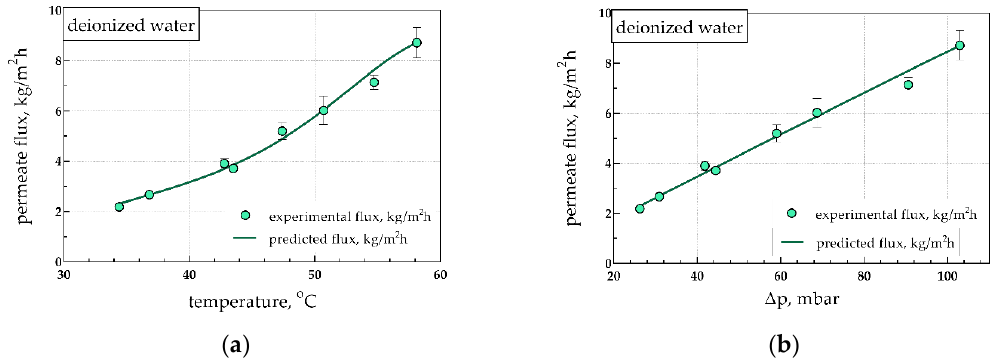
Figure 9. Comparison between values predicted by the model and experimental vapor flux data. Permeate flux versus: ( a ) the feed solution temperature, and ( b ) the driving force (vapor pressure-applied vacuum). Data from deionized water distillation.